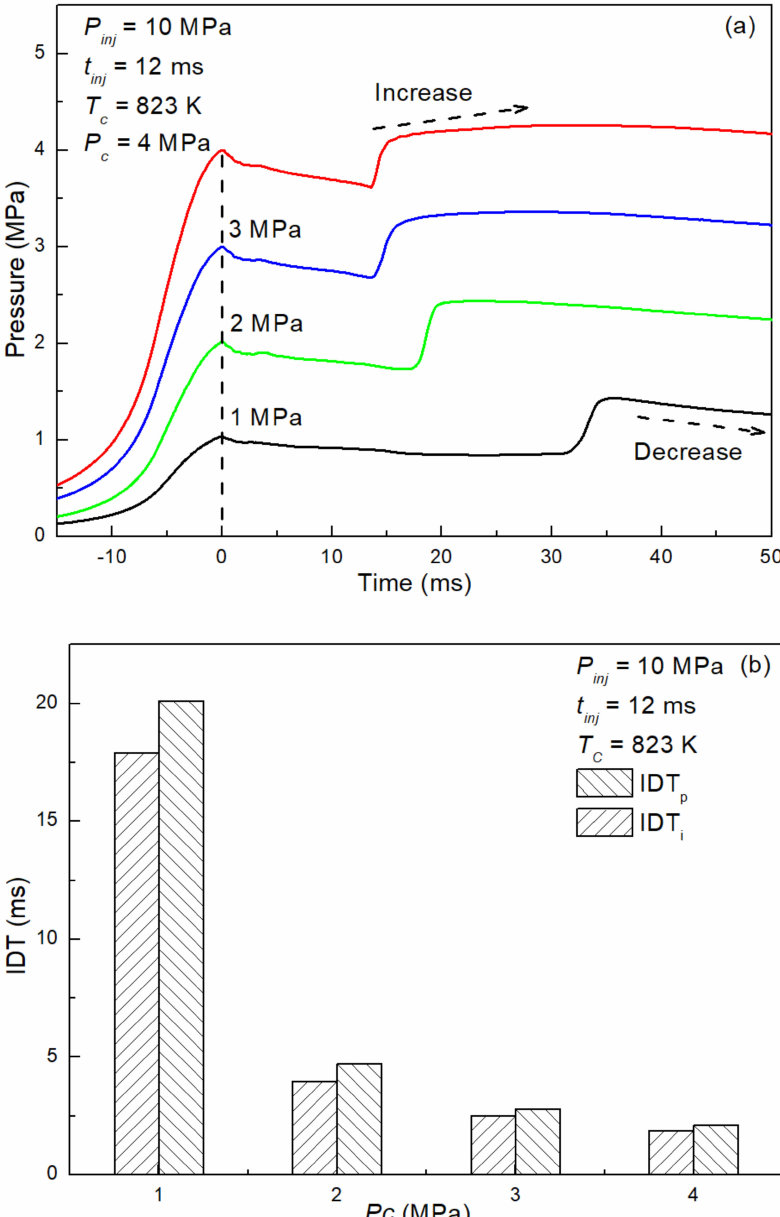
Figure 5. Effect of EOC pressure on pressure history ( a ) and IDT ( b